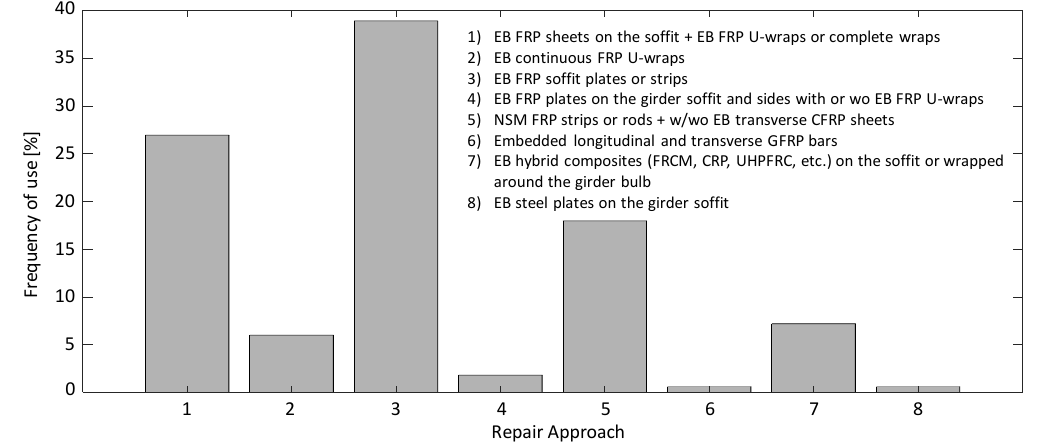
Figure 22. Frequency of use of flexural repair techniques of damaged RC girders in the literature.